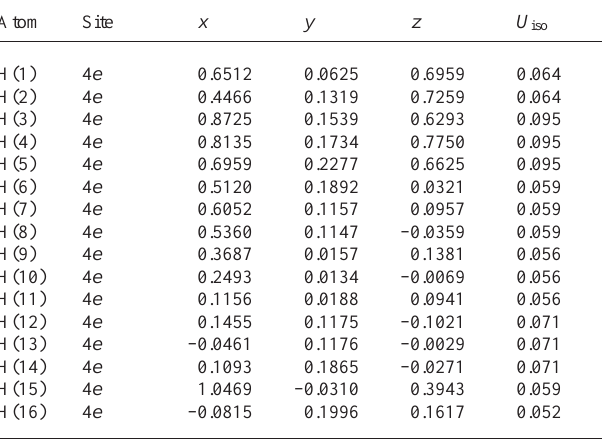
Table 2. Atomic coordinates and displacement parameters (in Å 2 )